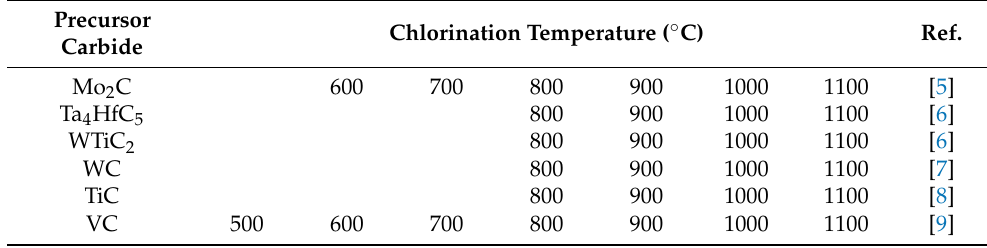
Table 1. The precursor carbides and corresponding chlorination temperatures of carbide-derived carbon powders